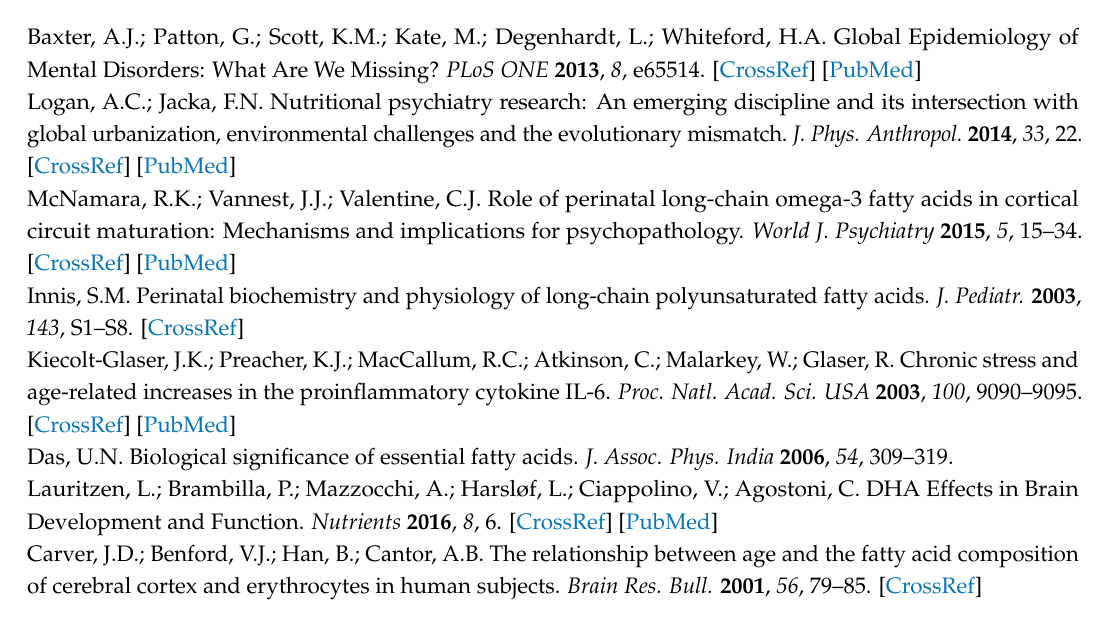
Figure 3. PRISMA diagram: ω -3 PUFAs supplementation in ASD.